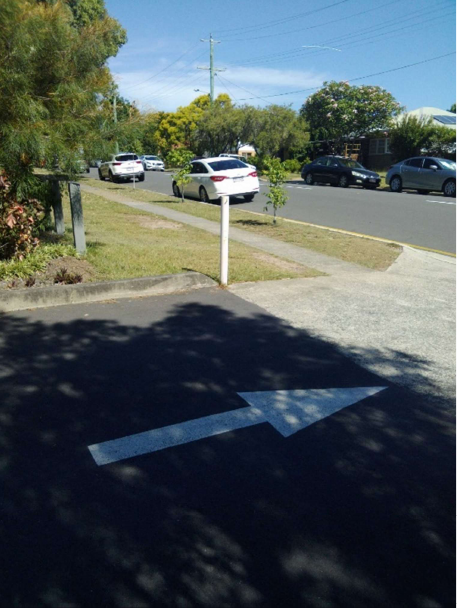
Figure 7. Likely to have an accident.